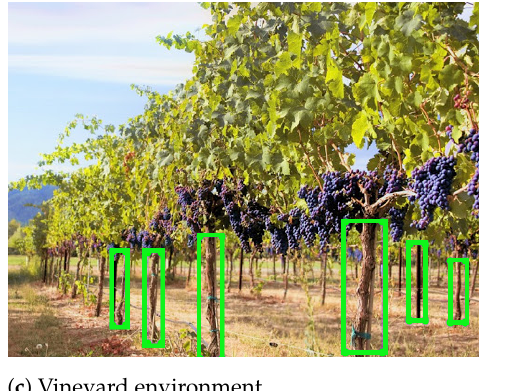
Figure 12. Automatic annotations in different areas of